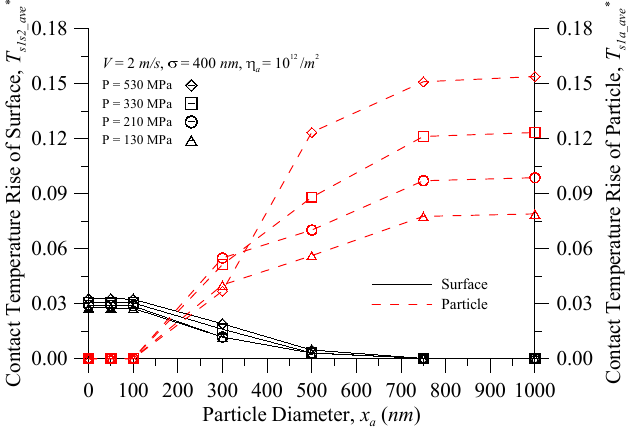
Figure 8. The contact temperature of the surface and particle vs. the particle diameter at various contact pressures.